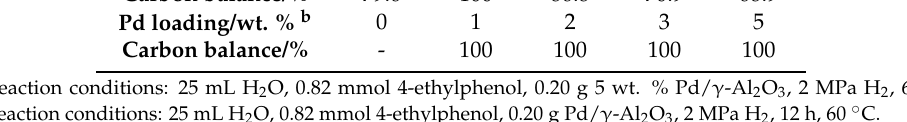
Figure 3. Effect of reaction temperature on the conversion of 4-ethylphenol and the selectivity to the products. Reaction conditions: 25 mL H 2 O, 0.82 mmol 4-ethylphenol, 0.20 g Pd/ γ -Al 2 O 3 , 2 MPa H 2 , 6 h. Table 2. Carbon balance of 4-ethylphenol hydrogenation on 5 wt. % Pd/ γ -Al 2 O 3 at different reaction temperature and on Pd/ γ -Al 2 O 3 with different Pd loading at 60 ˝ C. T/ ˝ C a